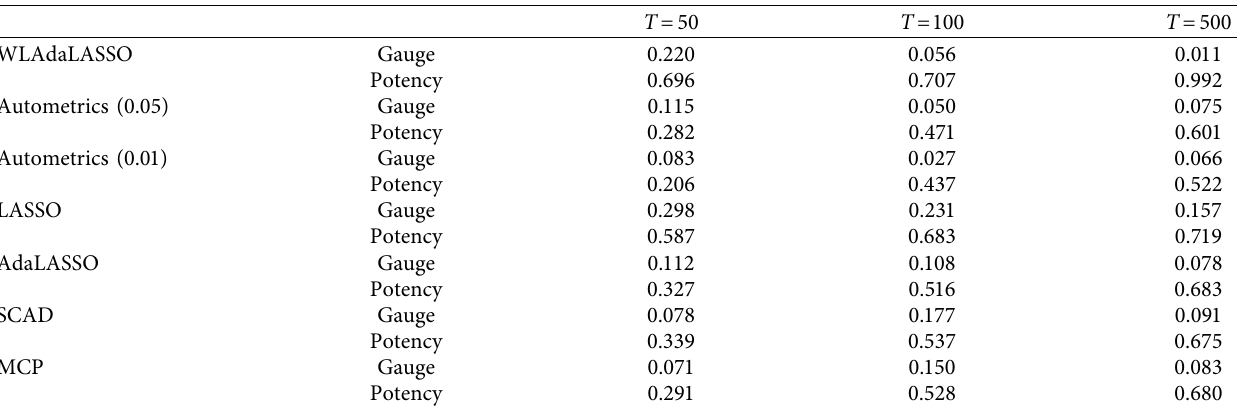
Table 3: Simulated result with ϕ equal to